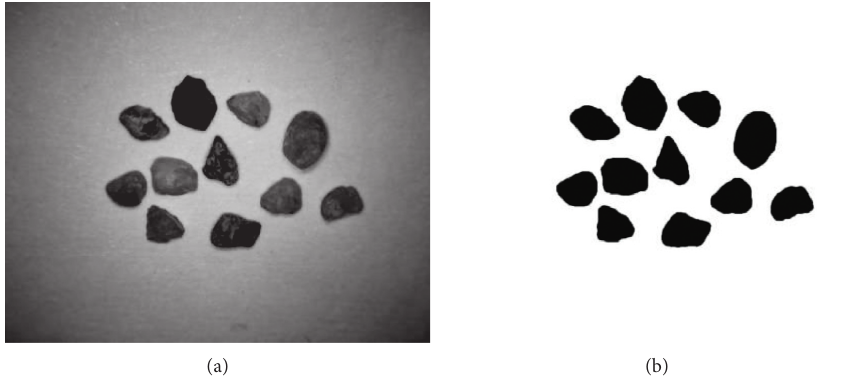
Figure 4: Microscope image and binarized image.